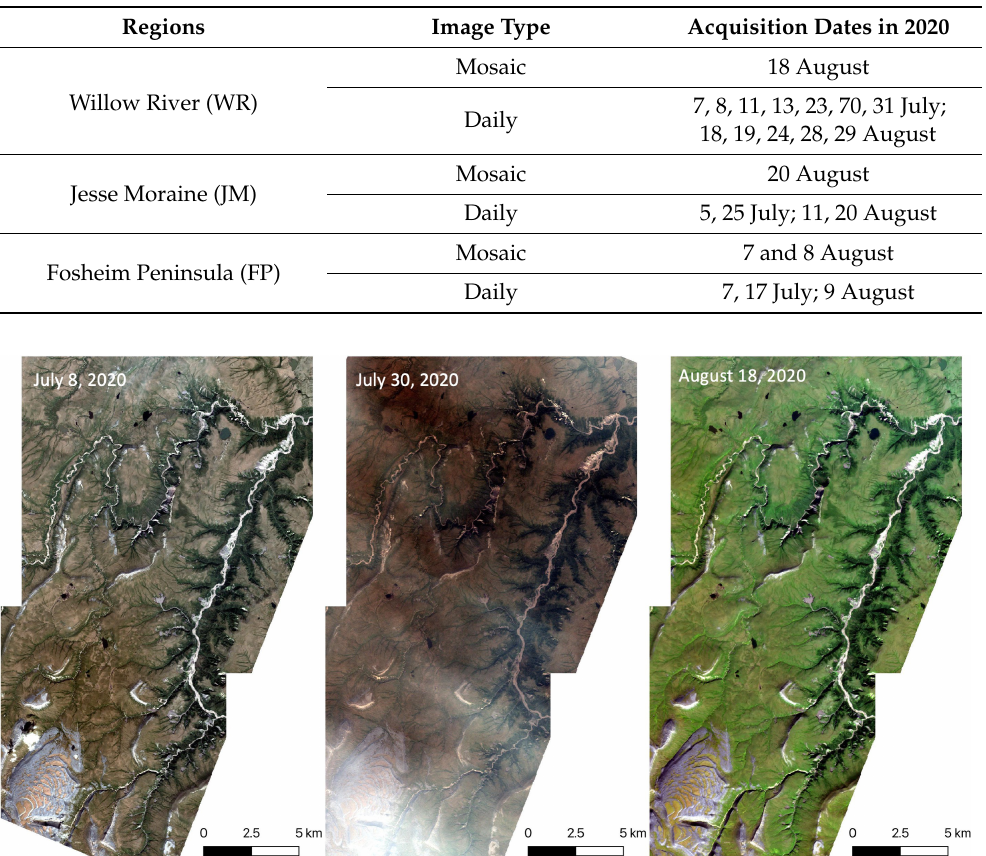
Table 1. PlanetScope images of the three study areas.